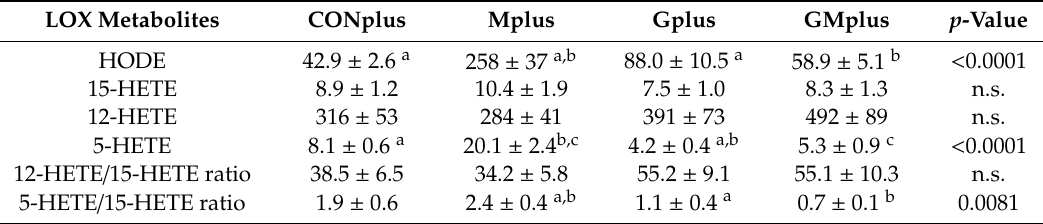
Table 2. Concentrations of linoleic and arachidonic acid lipoxygenase (LOX) metabolites (ng / mL) in serum of rats from experimental groups treated with chemical carcinogen